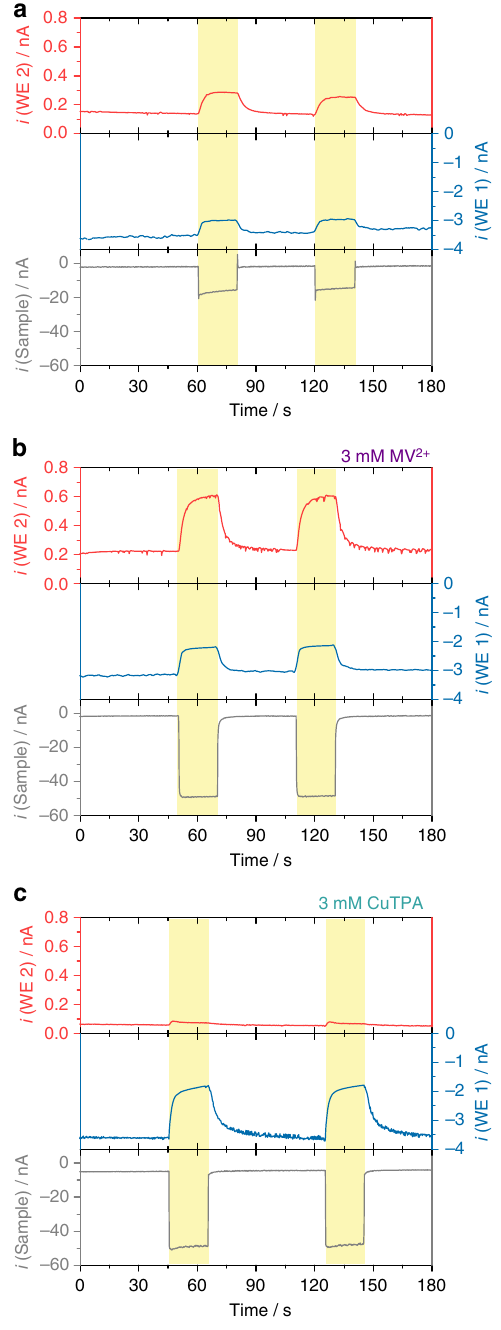
Fig. 3 Evidence for the generation of partially reduced oxygen species under irradiation. Simultaneous photochronoamperometric responses recorded during evaluation of a PS1/Os-complex-modi fi ed redox polymer photocathode on a gold electrode surface (sample) using a dual Pt microelectrode tip: a air-equilibrated buffer, b in the presence of 3 mM MV 2 + , c in the presence of 3 mM CuTPA. The sample was polarized at 0 mV while the Pt disk microelectrodes were polarized at − 600 mV (WE 1) and + 600 mV (WE 2) vs. Ag/AgCl/3 M KCl. Electrolyte: 0.2 M citrate- phosphate buffer, pH 7.0. Tip-to-sample distance: 10 μ m. The sample was locally irradiated (white light, 280 mW cm − 2 ) for periods of 20 s through the glass sheath of the positioned dual Pt microdisk electrode, as indicated by the yellow shaded regions in the